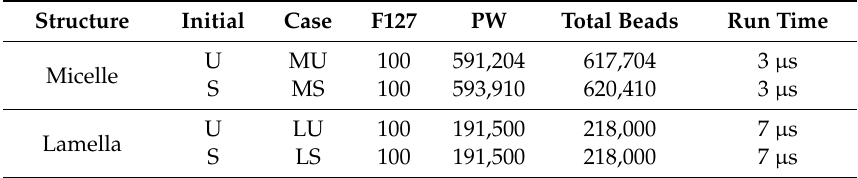
Table 1. Summary of the four simulated systems considered in this study. In the second column (Initial), the initial configuration of the polymer at the beginning of the simulation is reported. F127 indicates the number or polymer used in the system, and PW the number of water beads considered. Structure Initial Case F127 PW Total Beads Run Time U MU 100 591,204 617,704 3 µ s Micelle S MS 100 593,910 620,410 3 µ s U LU Lamella